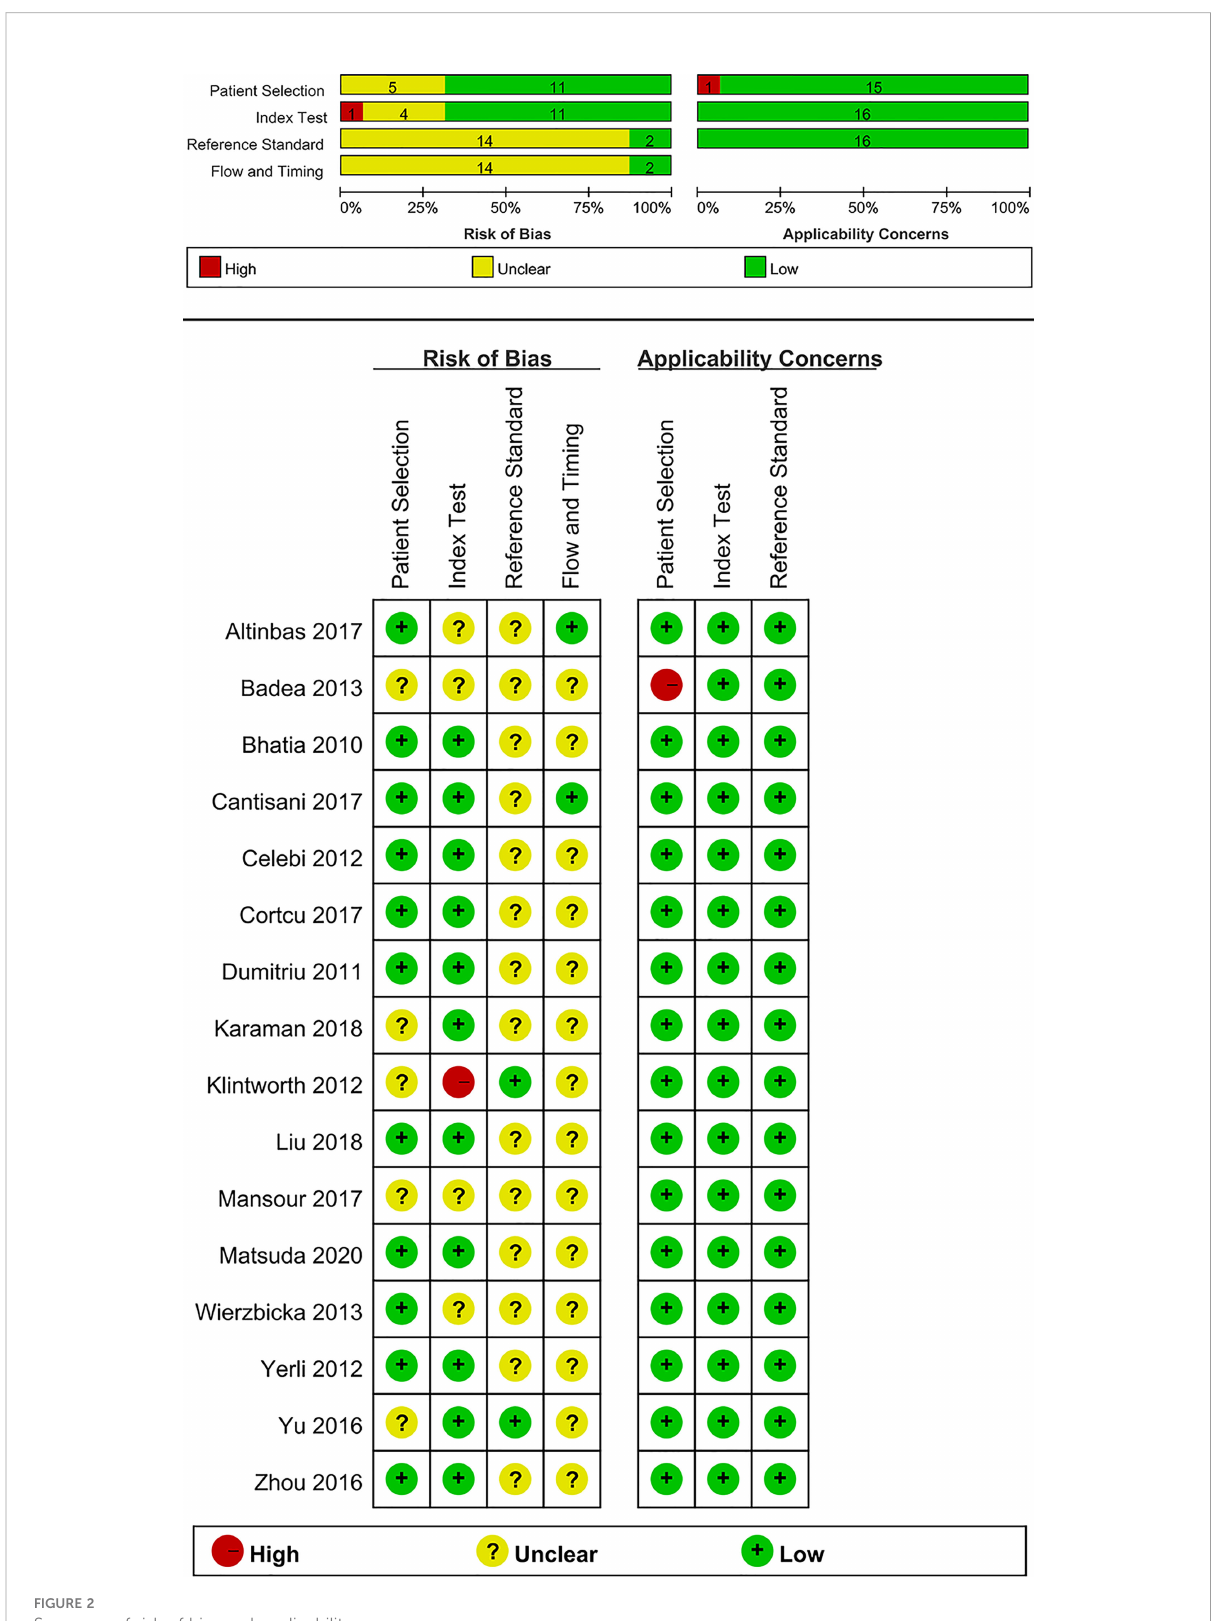
FIGURE 2 Summary of risk of bias and applicability